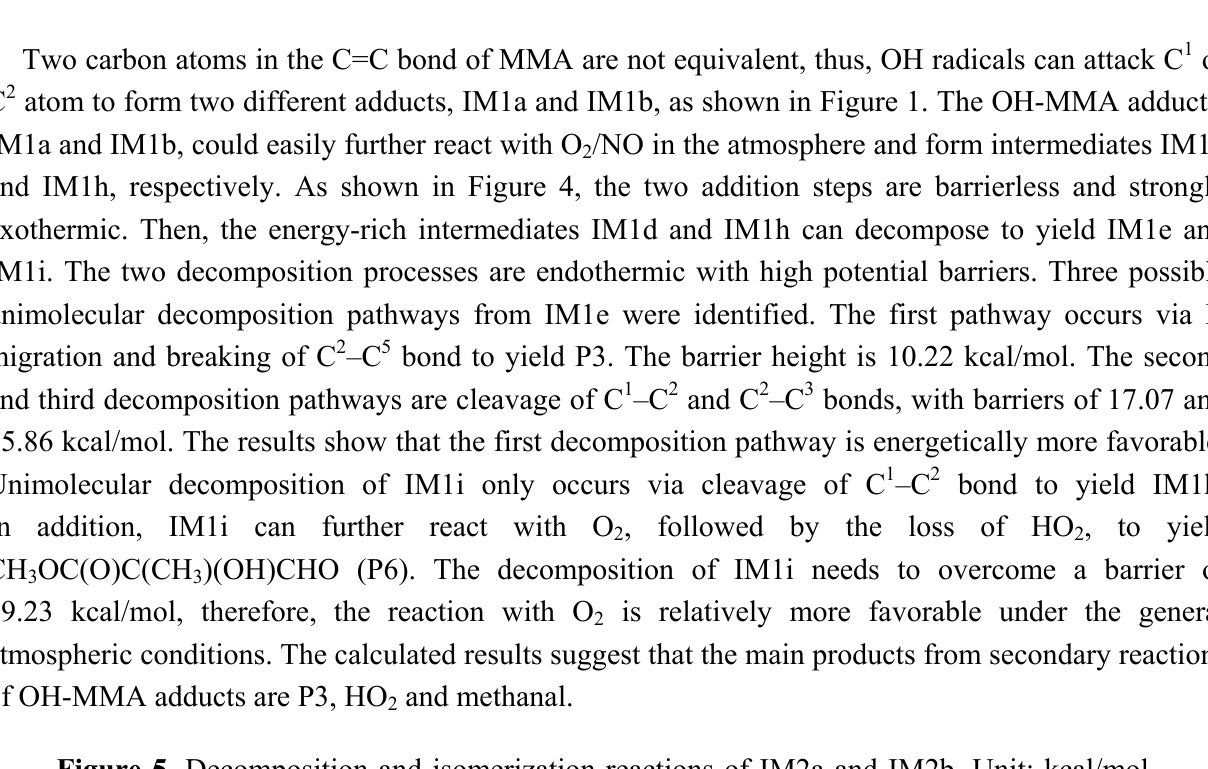
Figure 5. Decomposition and isomerization reactions of IM2a and IM2b. Unit: kcal/mol. Δ E: the potential barriers; Δ H : reaction heats (0